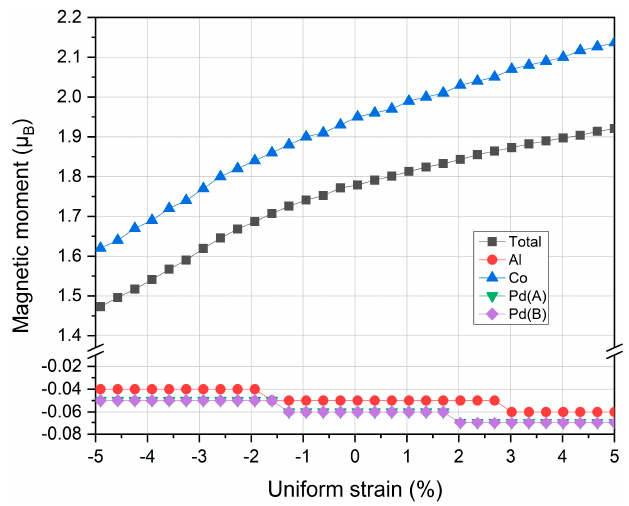
Figure 5. The calculated total and atom-resolved magnetic moments for the full Heusler compound Pd 2 CoAl in L2 1 -type under di ff erent uniform strains. Note the di ff erent scale of the two parts in the vertical